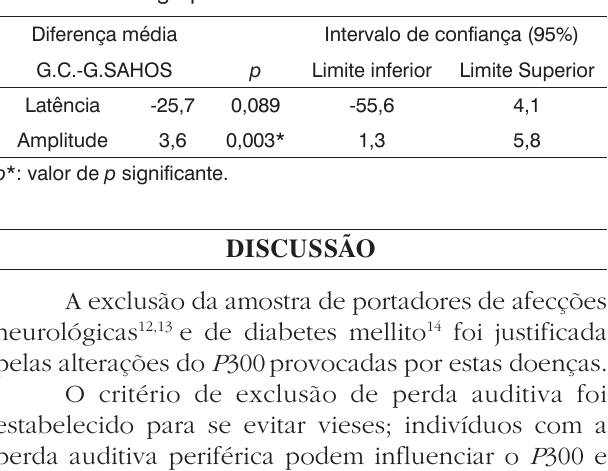
Tabela 5. Testes t de Student comparativo da Latência e Am- plitude entre os grupos G.C e G.SAOS.